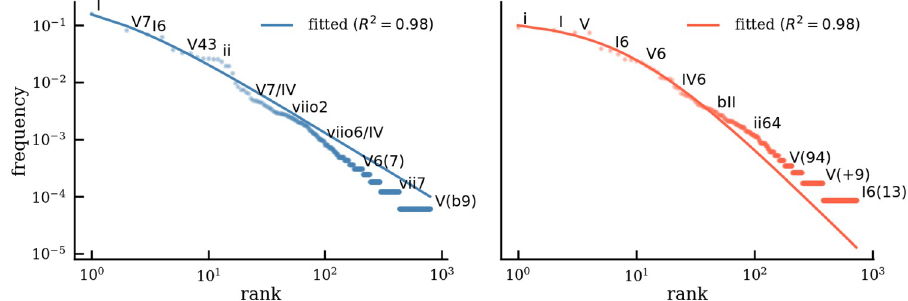
Fig 5. Chord frequency distribution. Rank vs. frequency plot of chords in major (left, blue) and minor (right, red) reveals an underlying power law. The solid line shows the best fit of a Zipf-Mandelbrot distribution as determined by the coefficient of determination R 2